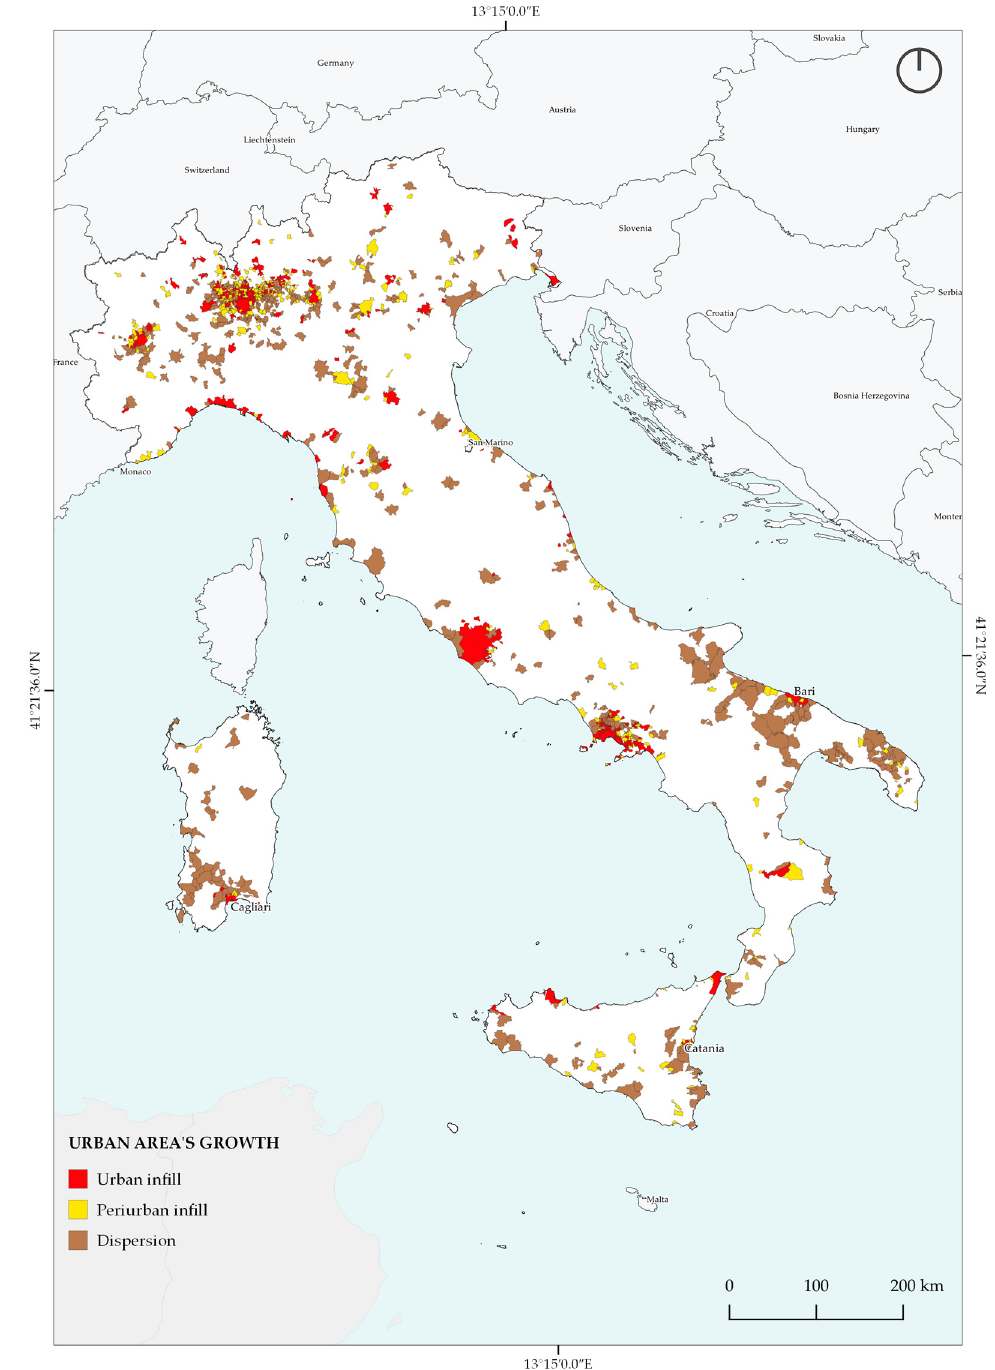
Figure 12. NDCL u , NDCL s , and NDCL r values in the municipalities classified as “Urban Center”, “Dense Urban Cluster”, and “Semi-dense Urban Cluster”. With the exception of the main capitals, in most urban municipalities, land consumption takes place in rural areas, assuming the characteristics of settlement dispersion.